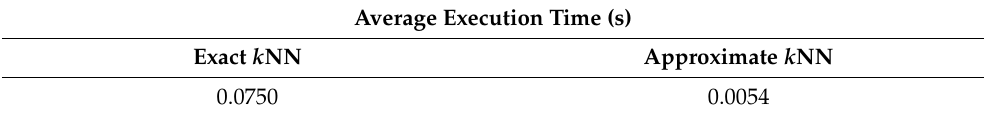
Table 1. Average computation overhead of original ODIT and efficient ODIT per